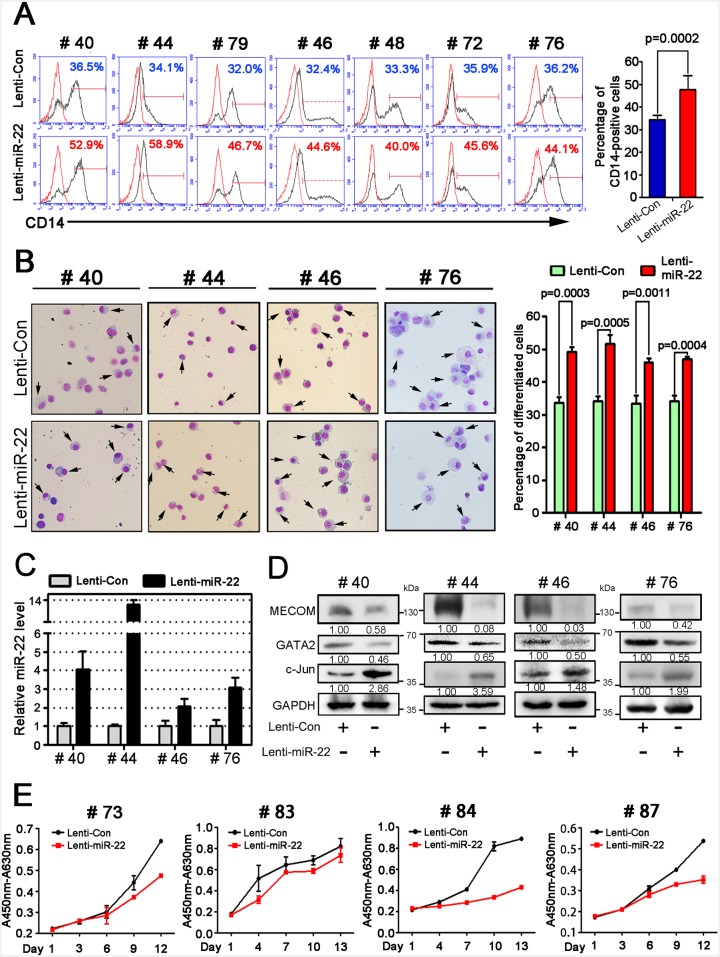
Reintroduction of miR-22 relieved monocyte/macrophage differentiation blockage and inhibited the growth of AML BM blasts.A. Flow cytometry analysis of CD14-positive cells in the monocyte/macrophage induction cultures of AML BM CD34+ HSPCs infected with Lenti-Con or Lenti-miR-22. The results from Day 9 are shown. The red-line curve represents the unstained cells. A statistical analysis of the seven samples is shown on the right. Error bars represent SD. B. Morphological analyses of the cells collected at Day 9. The cells were observed under 400 X magnification. A statistical analysis for counting differentiated monocytes/macrophages on five fields is presented on the right. C. qRT-PCR analysis of miR-22 confirmed the overpresence of miR-22 in the Lenti-miR-22-infected cells compared to the Lenti-Con-infected cells. D. Western blot analysis of MECOM, GATA2 and c-Jun levels in the cells collected on Day 6. E. Reinduction of miR-22 inhibited cell growth during the monocyte/macrophage induction culture of AML BM CD34+ HSPCs. BM CD34+ HSPCs obtained from patient #73, #83, #84 and #87 were infected with Lenti-miR-22 or Lenti-Con, cultured in an induction medium (including IL3, IL6, SCF, GM-CSF and FLT3) and harvested at the indicated time for CCK-8 detection.